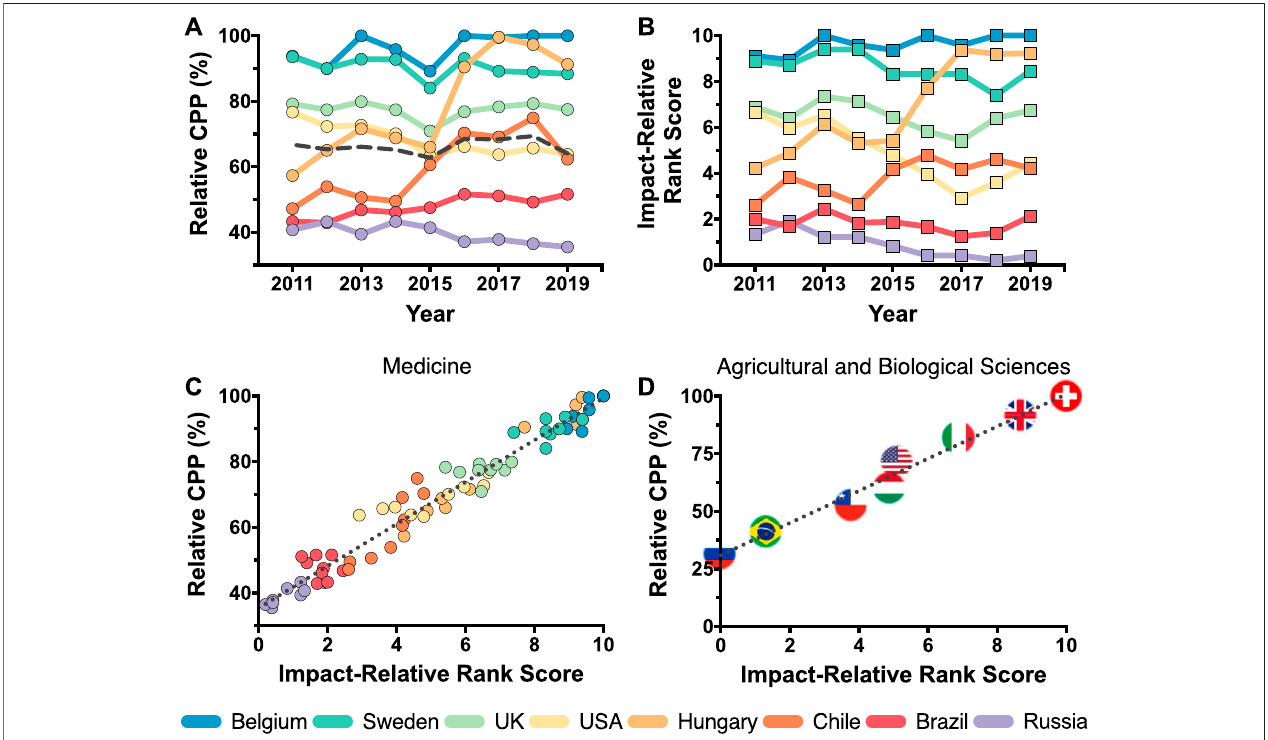
FIGURE 1 | New metrics for cross-country comparison of scienti fi c impact. (A) The relative citations per publication (CPP); and (B) The impact-relative rank score (IRSS) for medical publications, 2011 – 2019, Belgium, Brazil, Chile, Hungary, Russia, Sweden, the United Kingdom, the United States, and the world average (dashed lines). (C) Relative CPP vs. IRSS (dotted lined: linear regression y (cid:2) 35.42 + 6.39 x ; R 2 (cid:2) 0.96; data from panels A and B ). (D) Relative CPP vs. IRSS, agricultural and biologicalarea. Russia, Brazil, Chile,Italy,the United States, Hungary, the United Kingdom, and Switzerland,2018(dotted line:linearregression y (cid:2) 30.94 +6.99 x ; R 2 (cid:2) 0.98). All data retrieved from Scimago (Scimago Lab, 2019)